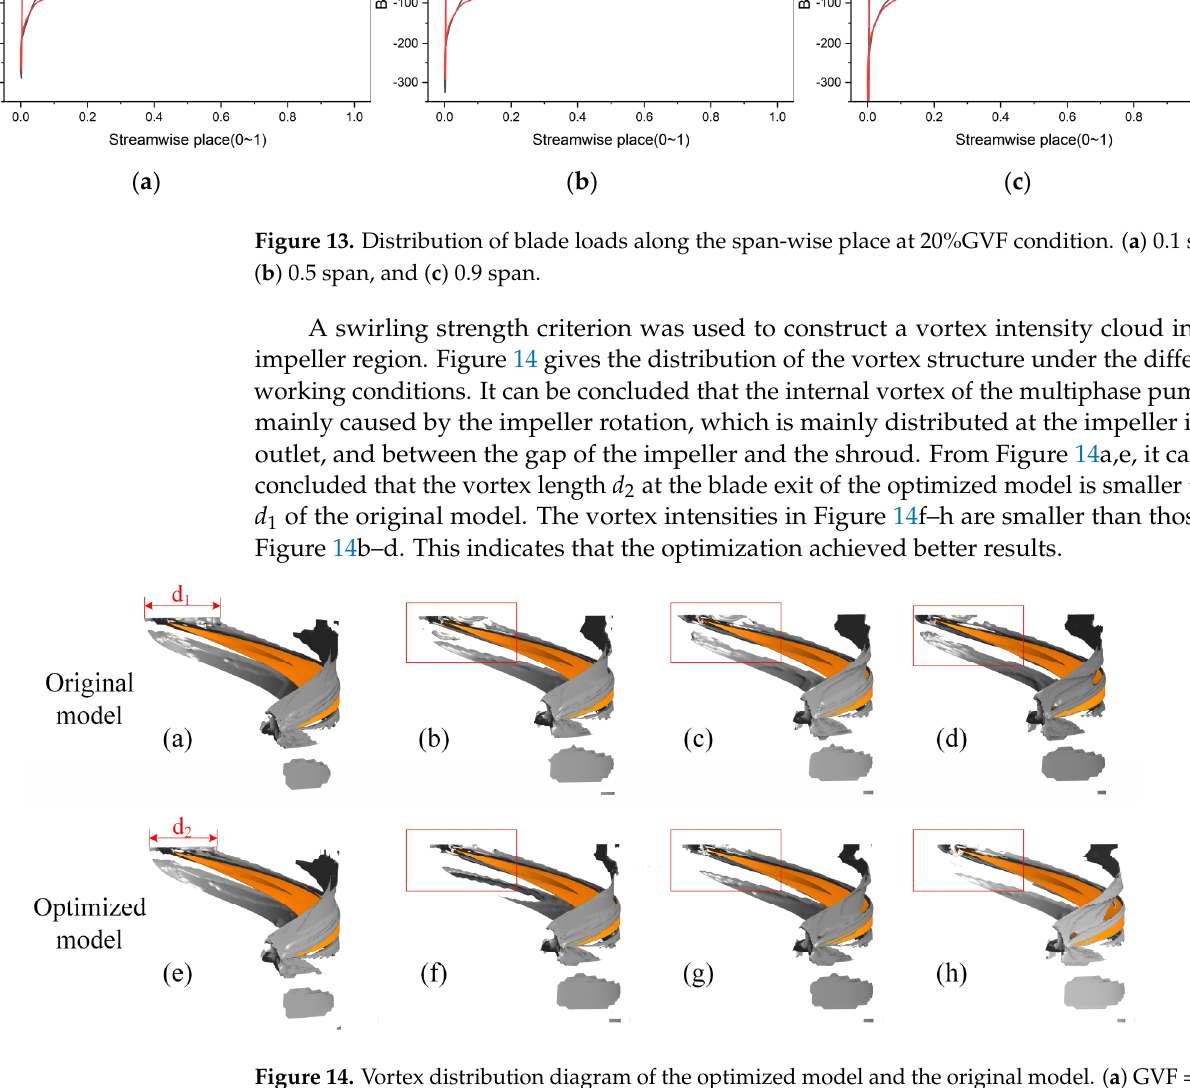
Figure 14. Vortex distribution diagram of the optimized model and the original model. ( a ) GVF = 0 of original model; ( b ) GVF = 10% of original model; ( c ) GVF = 20% of original model; ( d ) GVF = 30% of original model; ( e ) GVF = 0 of optimized model; ( f ) GVF = 10% of optimized model; ( g ) GVF = 20% of optimized model; ( h ) GVF = 30% of optimized model.